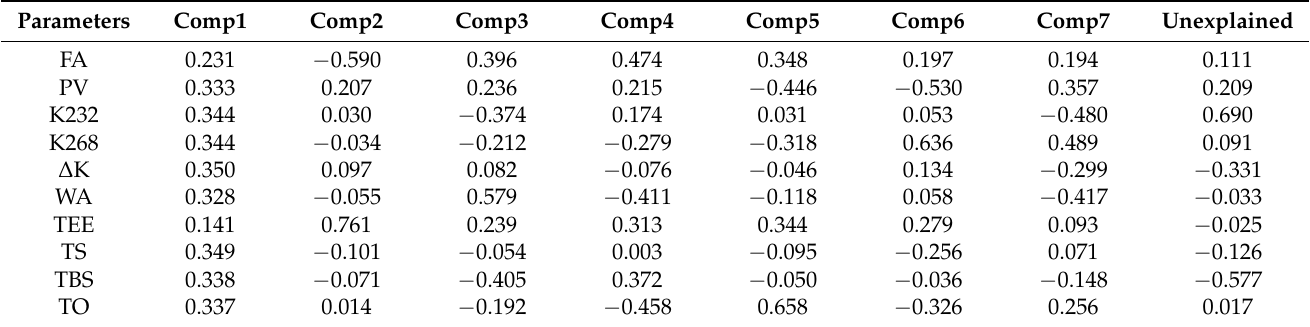
Figure 5. ( a ) Component loadings of quality parameters in two EVOO cultivars by different malaxation methods (T0 and T20). First two principal component (Component 1 x -axis, Component 2 y -axis) analysis (PCA). ( b ) Predicted scores after PCA obtained as linear combination of the observation data by using eigenvector of component 1 ( x -axis) and eigenvector of component 2 ( y -axis). Table 3. Component loadings of the quality parameters of EVOOs.